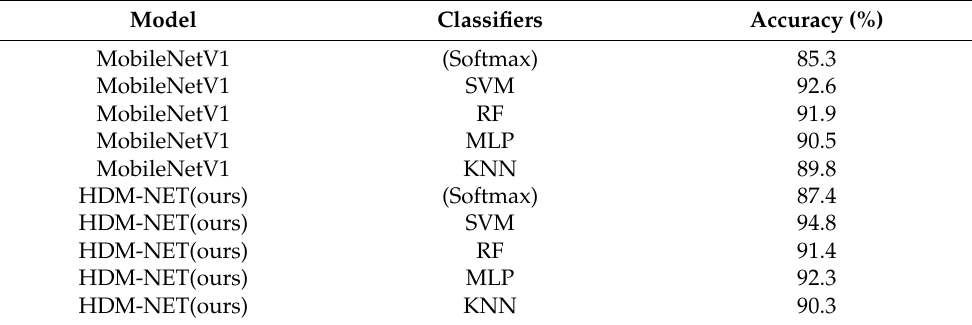
Table 2. Results of MobileNetV1 and HDM-NET on DHI datasets.